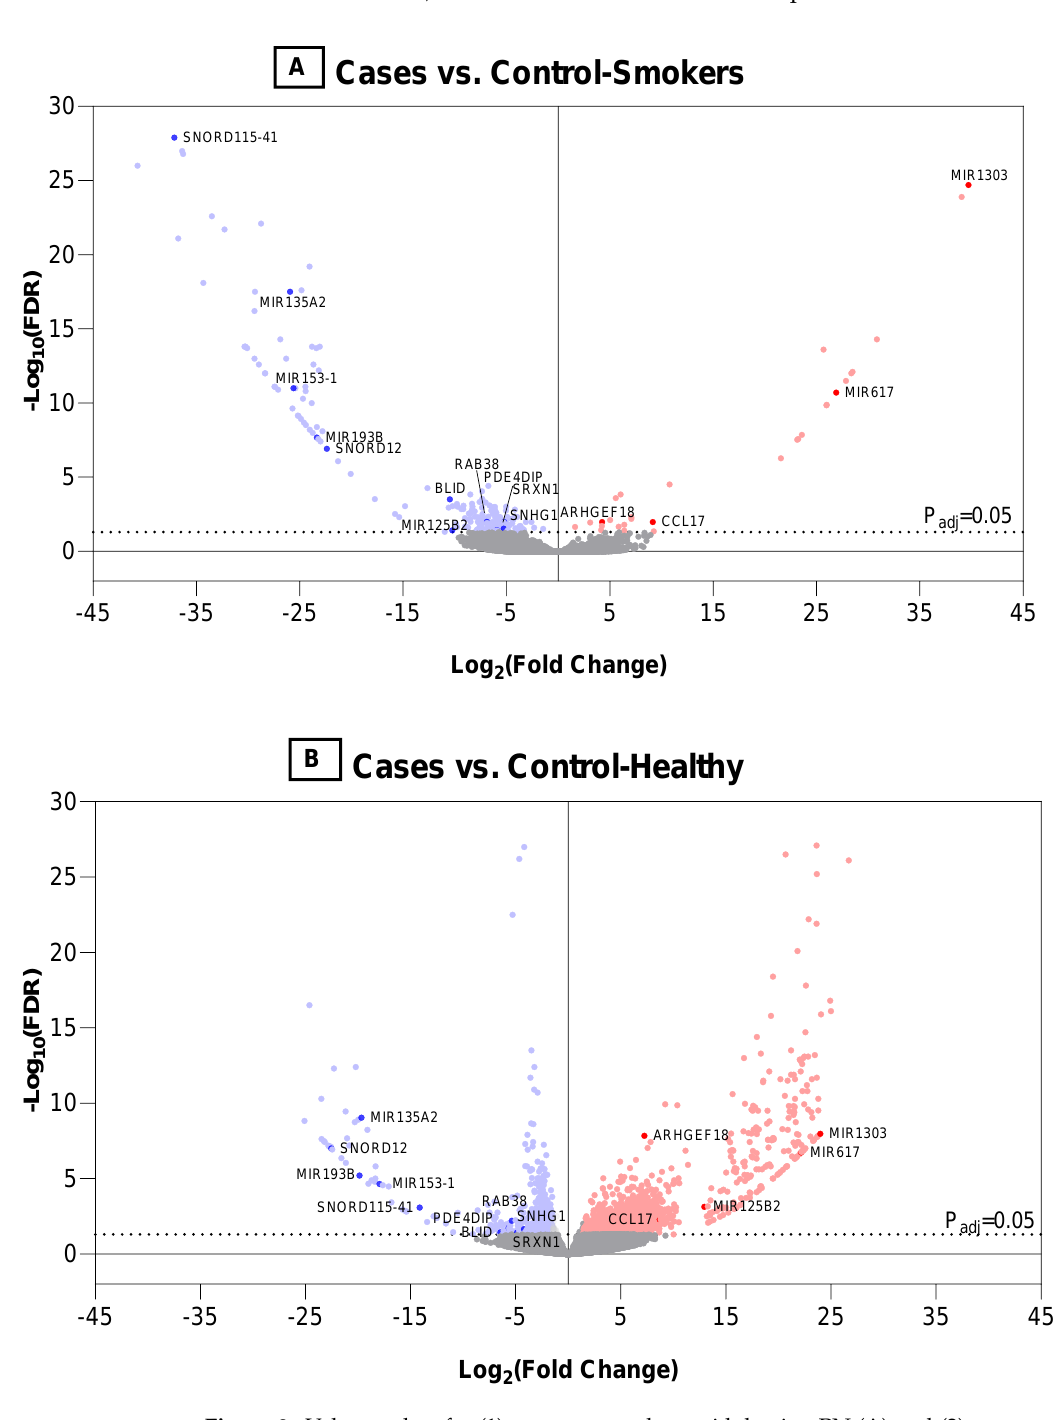
Figure 2. Volcano plots for (1) cases vs. smokers with benign PN ( A ) and (2) cases vs. healthy non- smokers ( B ). The horizontal dotted lines indicate an adjusted p -value of 0.05. The dots are colored blue or red if classified as down- or up-regulated, respectively, using a threshold of log 2-fold change of − 1 and 1.